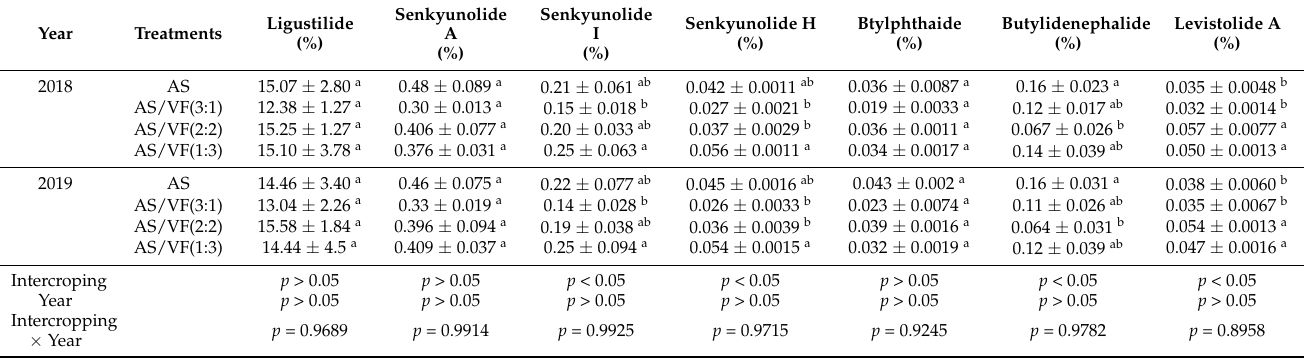
Table 5. Essential oil compositions of A. sinensis under different cropping systems in 2018 and in 2019 1 .